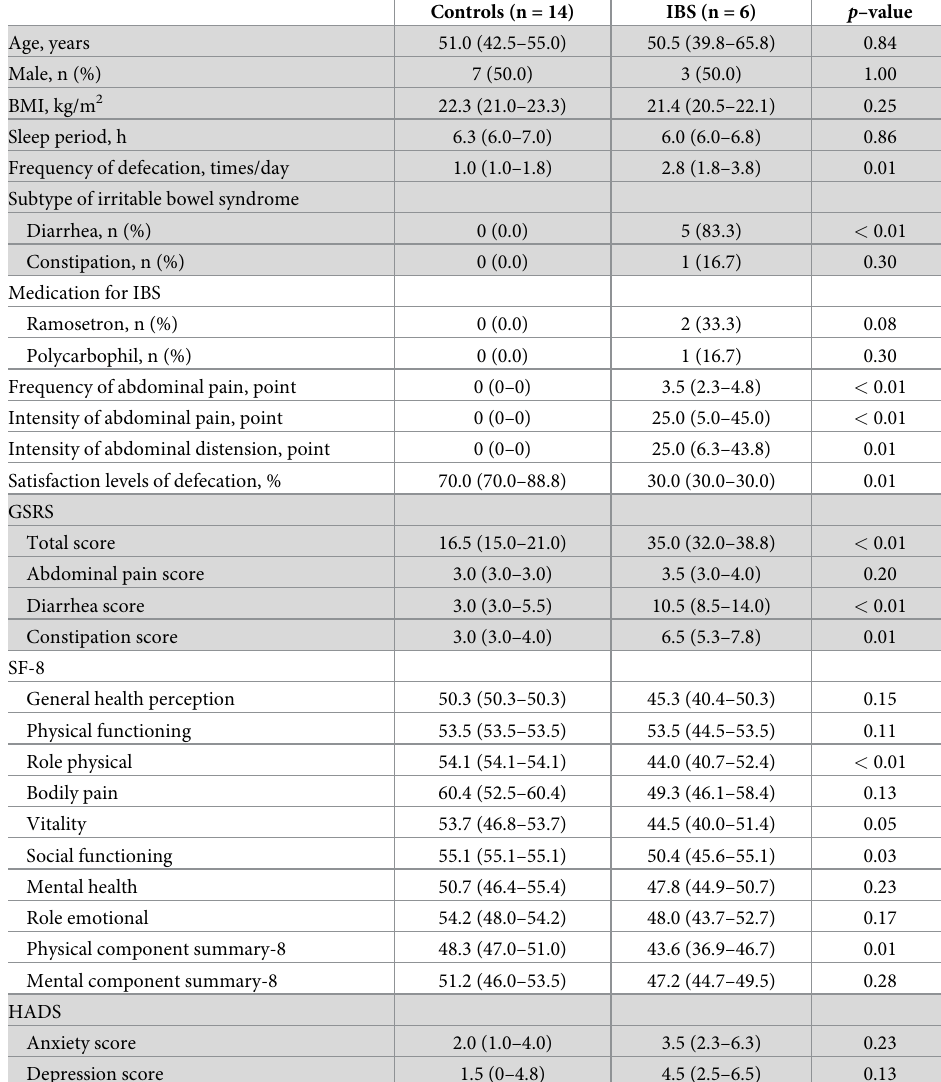
Table 1. Background